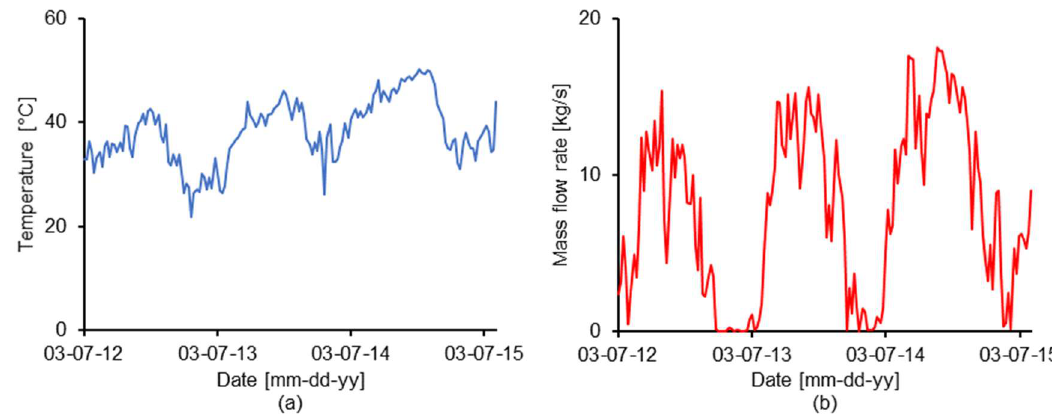
Figure5. Measuredstoragesupplyflowtemperature( a )andmassflowrate( b Figure 5. Measured storage supply flow temperature ( a ) and mass flow rate ( b ) at weekly average values.